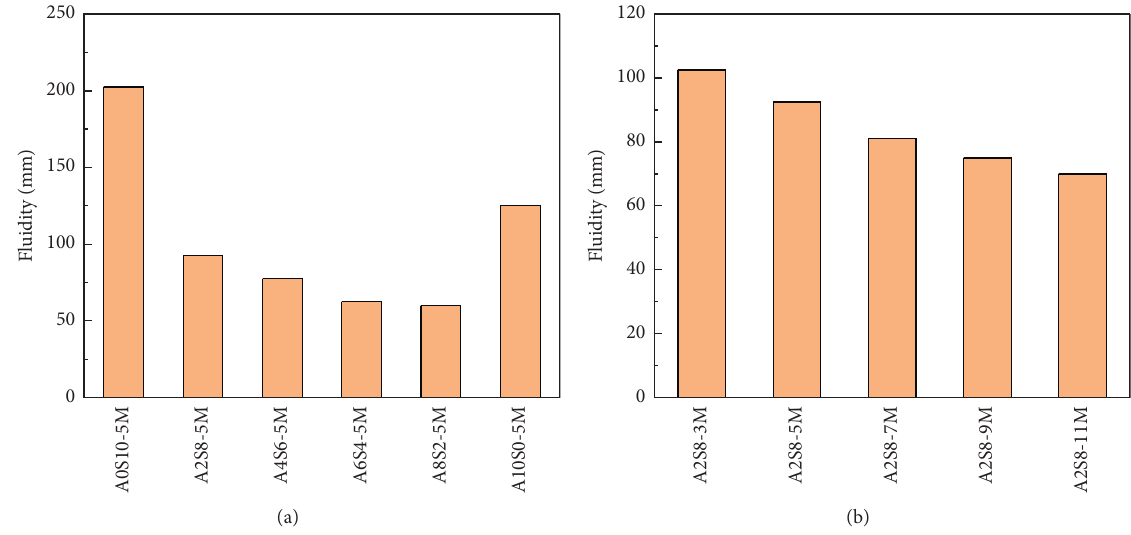
Figure 4: AAS fluidity with different NaAlO 2 dosages and Na 2 O contents. (a) Different NaAlO 2 dosages and (b) different Na 2 O